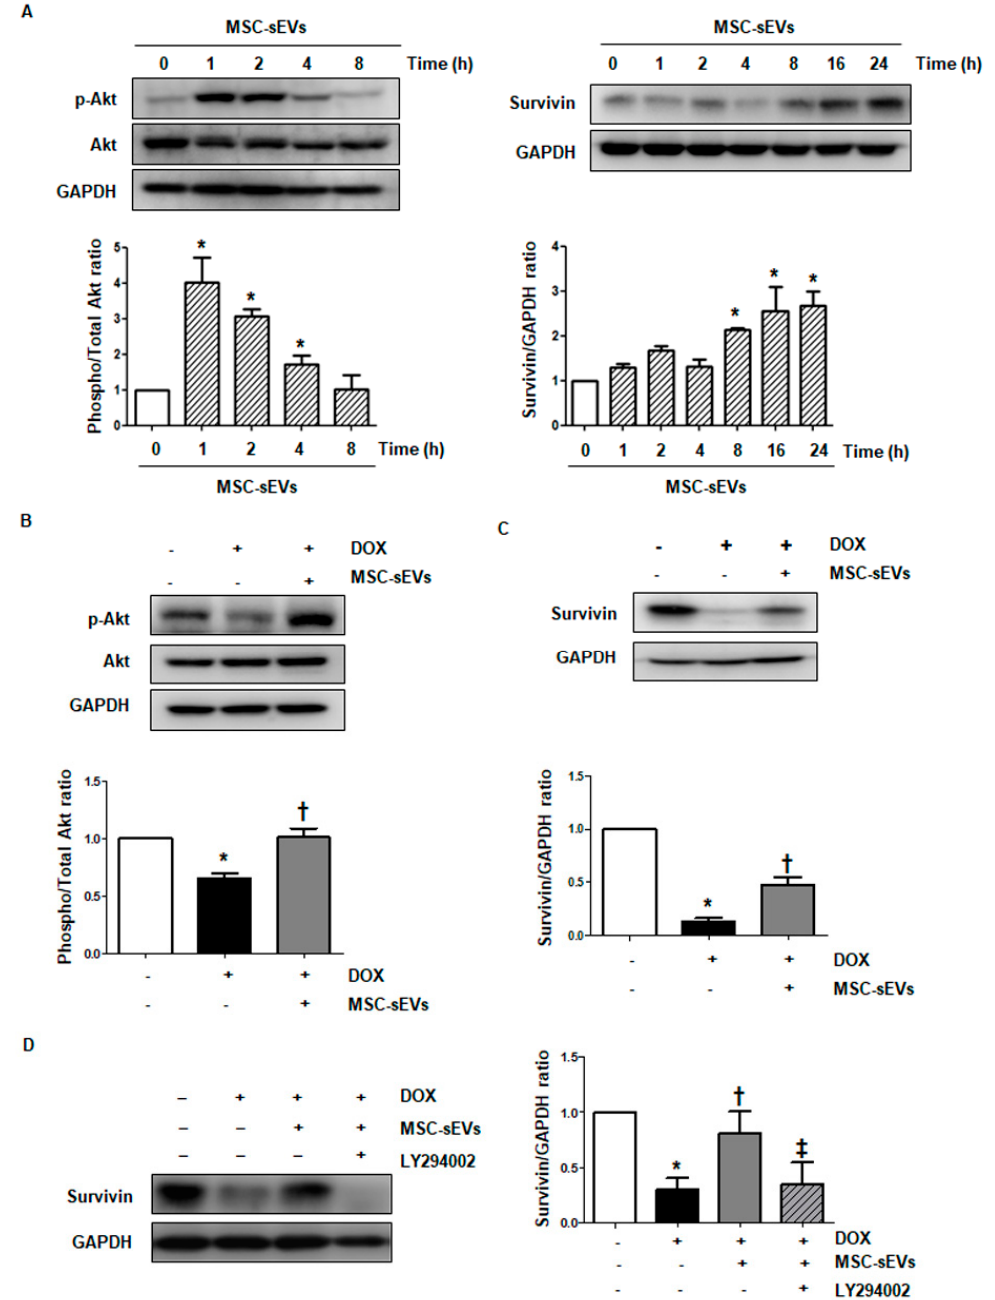
Figure 2 . MSC − sEVs inhibit DOX − induced downregulation of survivin via the activation of Akt in cardiomyocytes. ( A ) H9c2 cells were treated with MSC − sEVs (3 × 10 9 ) for the indicated times. The protein levels of p − Akt, Akt, survivin, and GAPDH were measured by Western blotting. * Significant difference compared to the control ( p < 0.05). ( B , C ) H9c2 cells were cultured in DOX (1 μ M) for 8 or 24 h after 24 h of exposure to MSC − sEVs. The protein levels of p − Akt, Akt, survivin, and GAPDH were measured by Western blotting ( n = 5). * Significant difference compared to the control ( p < 0.05). † Significant difference compared to DOX treatment ( p < 0.05). ( D ) After treatment with LY294002 (50 μ M) for 2 h, the cells were exposed to MSC − sEVs (3 × 10 9 ) for 24 h and then additionally treated with DOX (1 μ M) for 24 h. The protein levels of survivin and GAPDH were measured by Western blotting ( n = 5). * Significant difference compared to the control ( p < 0.05). † Significant difference compared to DOX treatment ( p < 0.05). ‡ Significant difference compared to MSC − sEVs + DOX treatment ( p < 0.05).